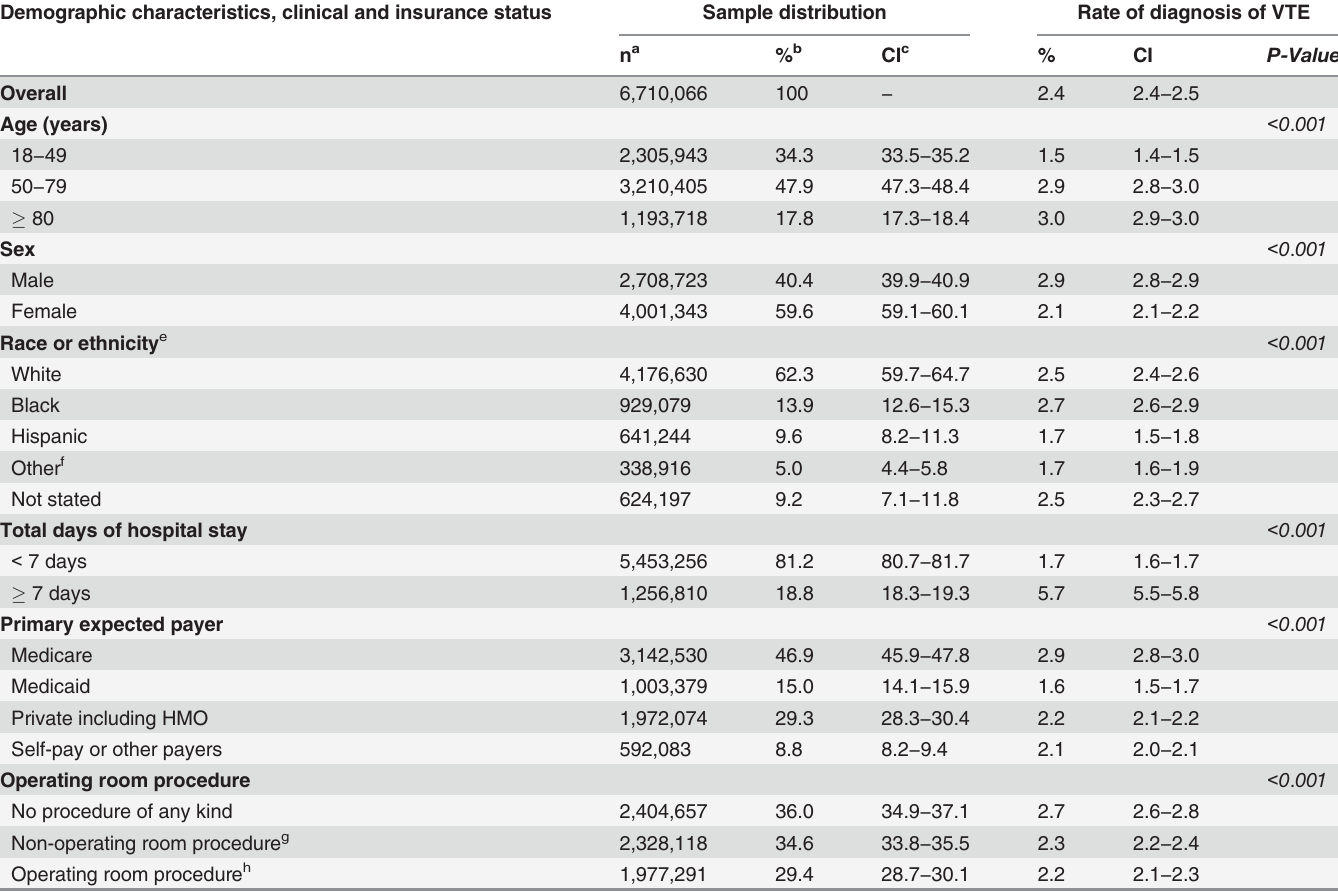
Table 1. Percentage distribution and rate of VTE diagnosis among hospitalizations of US adults by demographic characteristics, clinical and in- surance status, NIS, 2011. Demographic characteristics, clinical and insurance